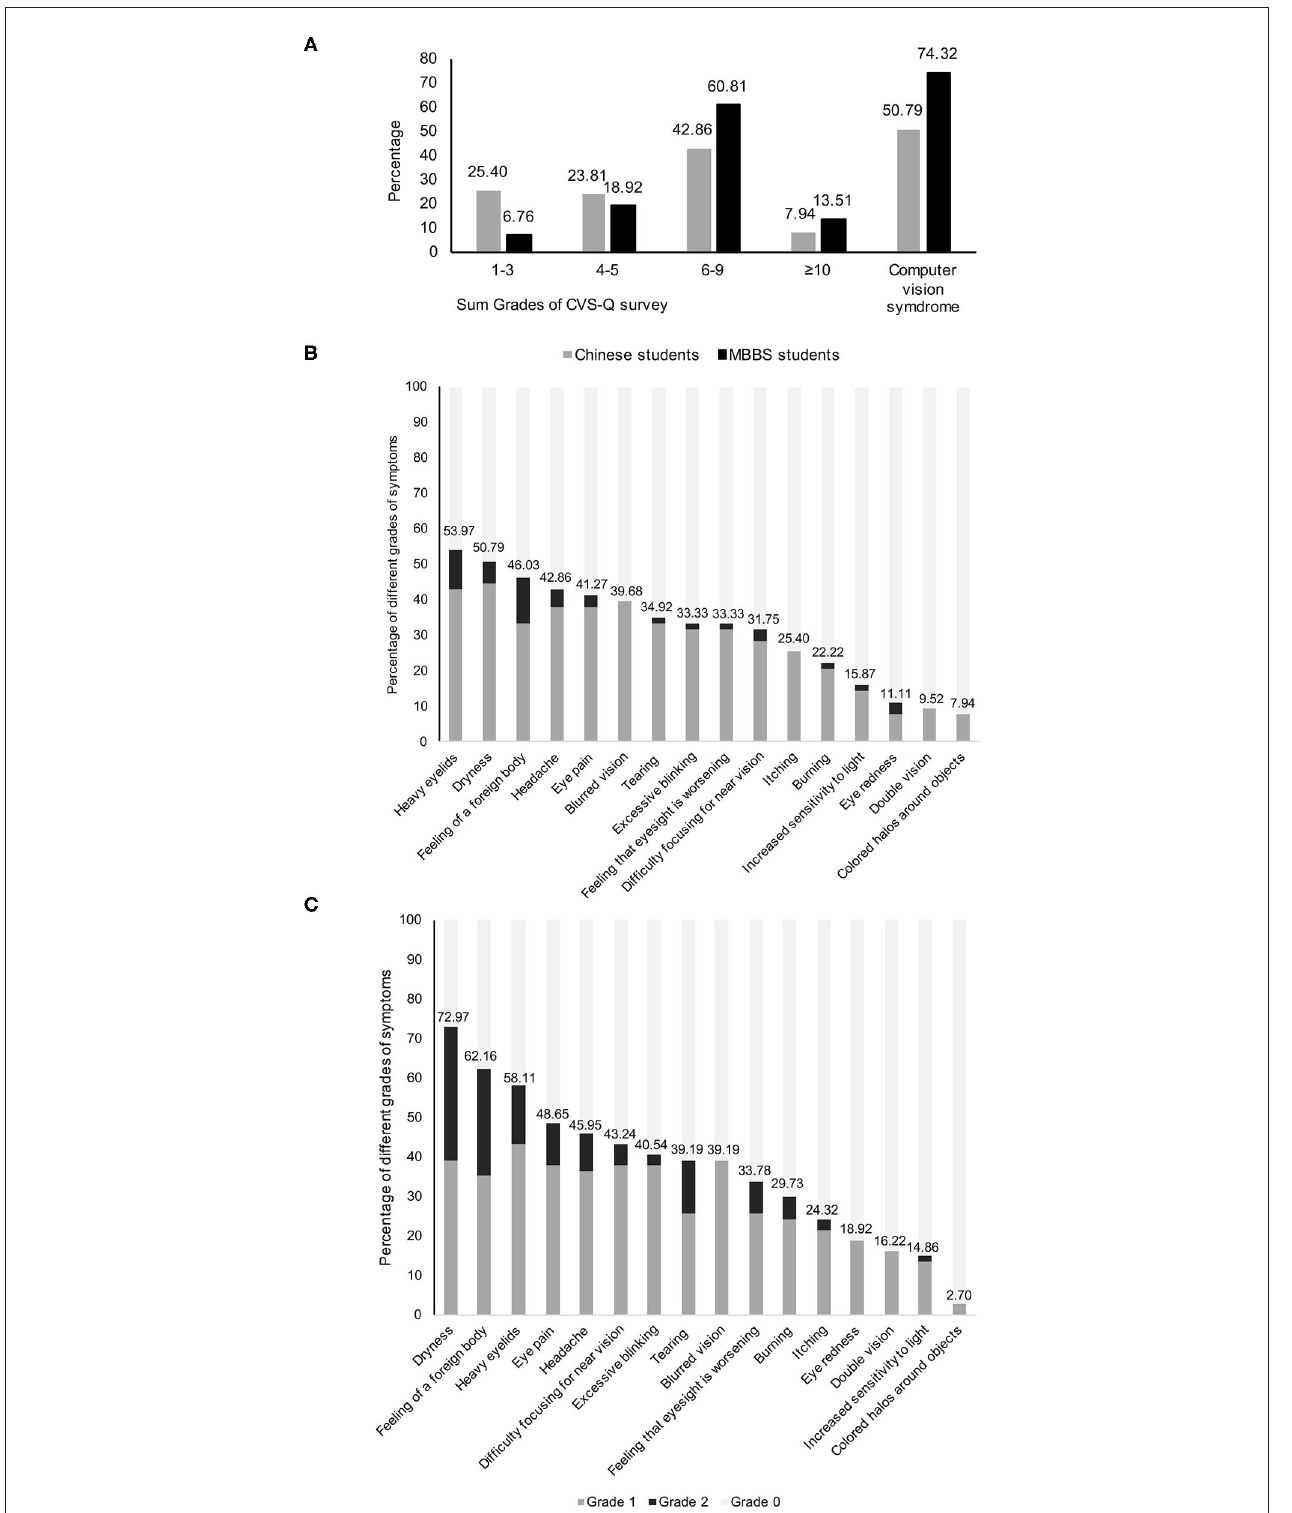
FIGURE 2 | Computer vision syndrome among responders. (A) Distribution of sum grades of computer vision syndrome of Chinese and MBBS students; (B) grades of each symptom of computer vision syndrome questionnaire in Chinese students; (C) grades of each symptom of computer vision syndrome questionnaire in MBBS